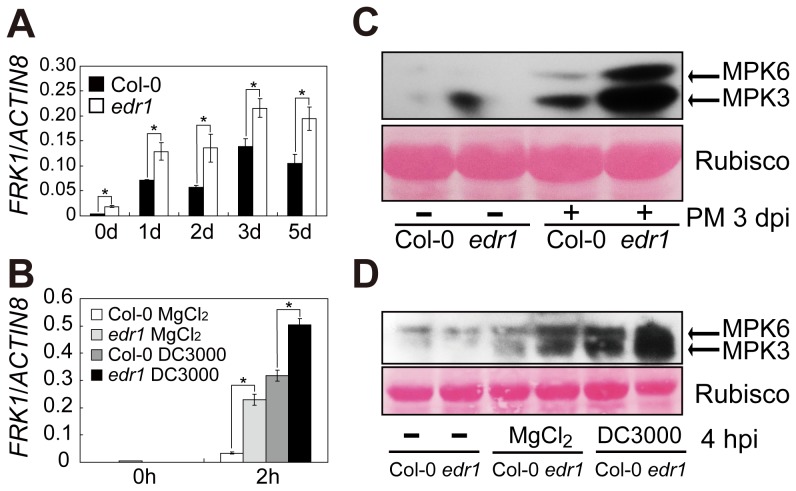
EDR1 negatively regulates the kinase activity of MPK3 and MPK6.(A–B) The transcript accumulation of FRK1 was measured by quantitative real-time RT-PCR. Leaves were collected for RNA isolation at different time points after infection with G. cichoracearum (A) or Pto DC3000 (in 10 mM MgCl2) (B). Error bars represent the standard deviation of three biological replicates. Asterisks indicate statistically significant differences (P<0.05, Student's t-test). (C–D) The plants were infected with G. cichoracearum (C) and Pto DC3000 (D), respectively. Immunoblotting was performed using an anti-phospho-p44/42 MAPK (Thr202/Tyr204) (anti-pTEpY) antibody. The large subunit of Rubisco is shown as a protein loading control. The experiment was repeated at least three times with similar results. PM: powdery mildew infection.